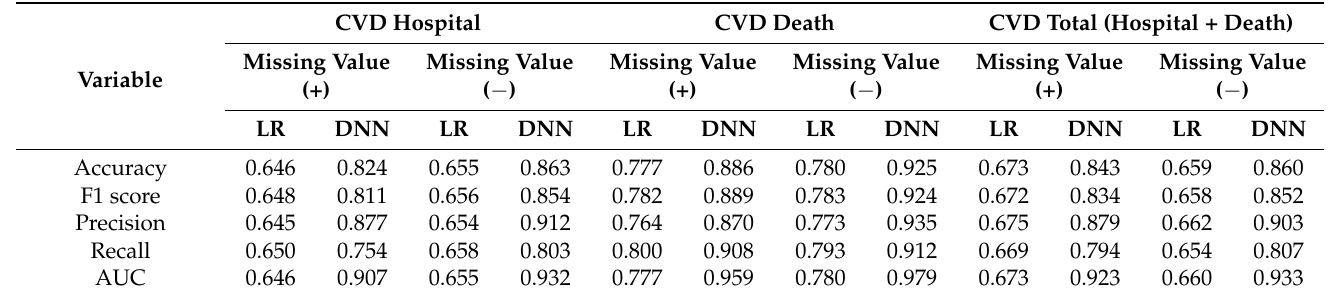
Table 3. Performances of logistic regression and deep neural network models for main outcomes.